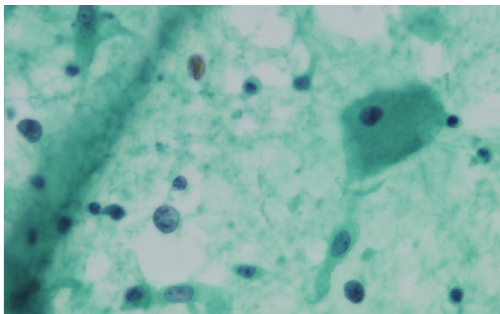
Figure 3: Fine-needle aspiration showing the eosinophilic cyto- plasm of duct epithelial cells and the presence of naked nuclei with prominent